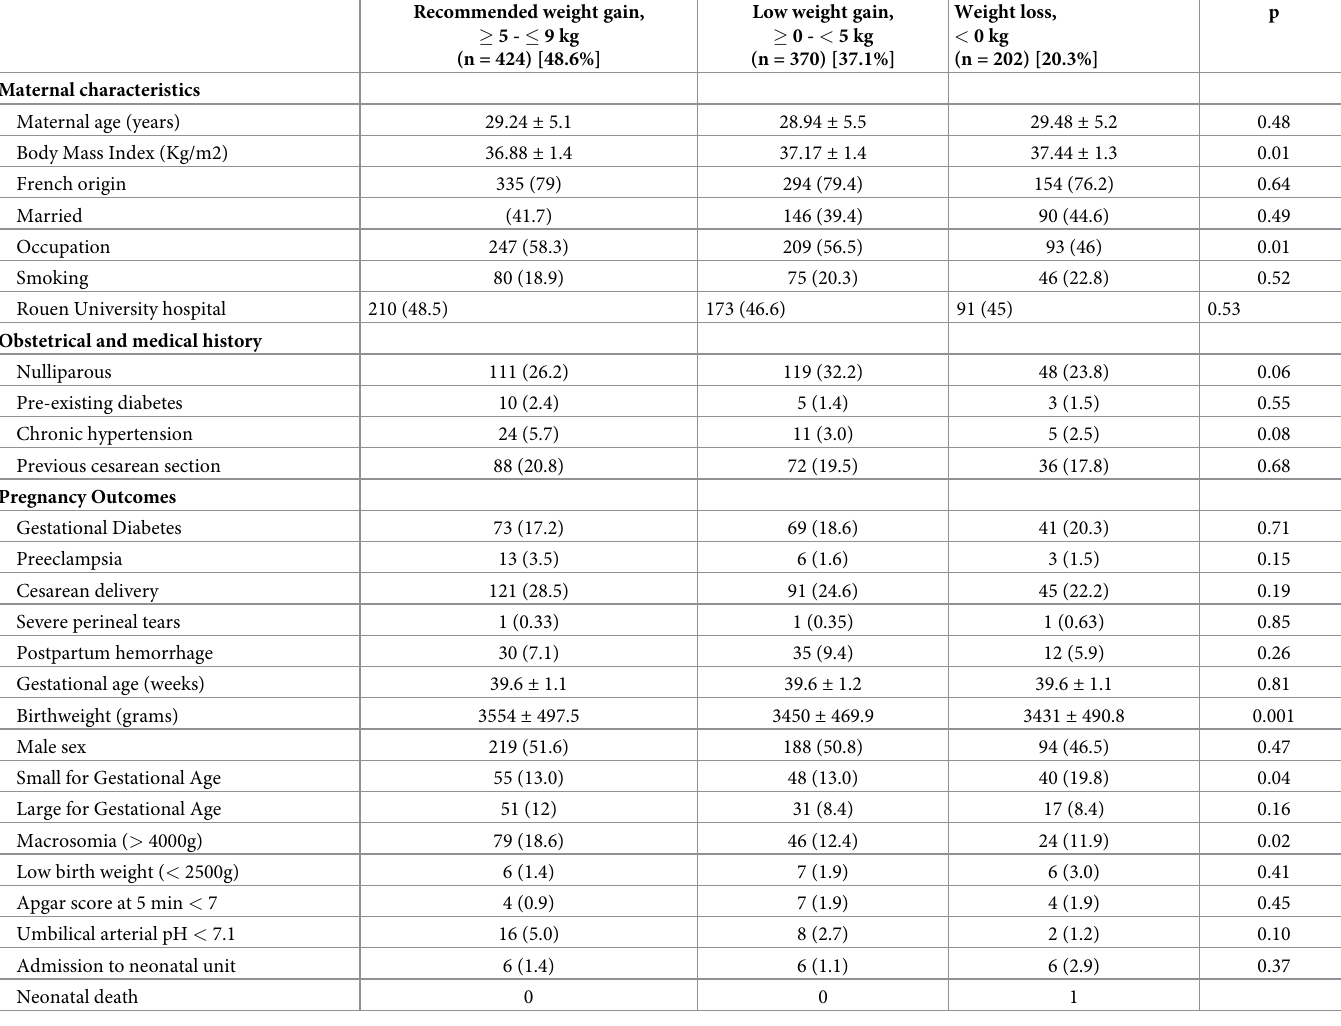
Table 1. Maternal and pregnancy characteristics of women with class II obesity by gestational weight